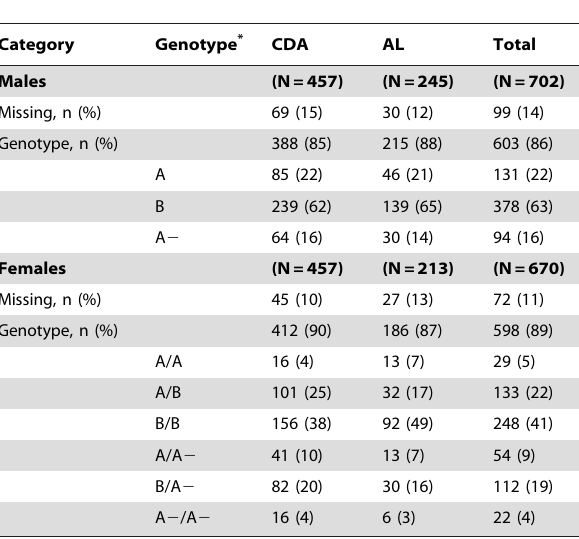
Figure 1. Trial profile.